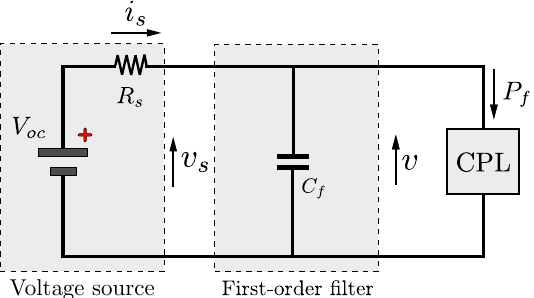
Figure 3. Scheme of the equivalent electrical circuit of the first-order input filter with